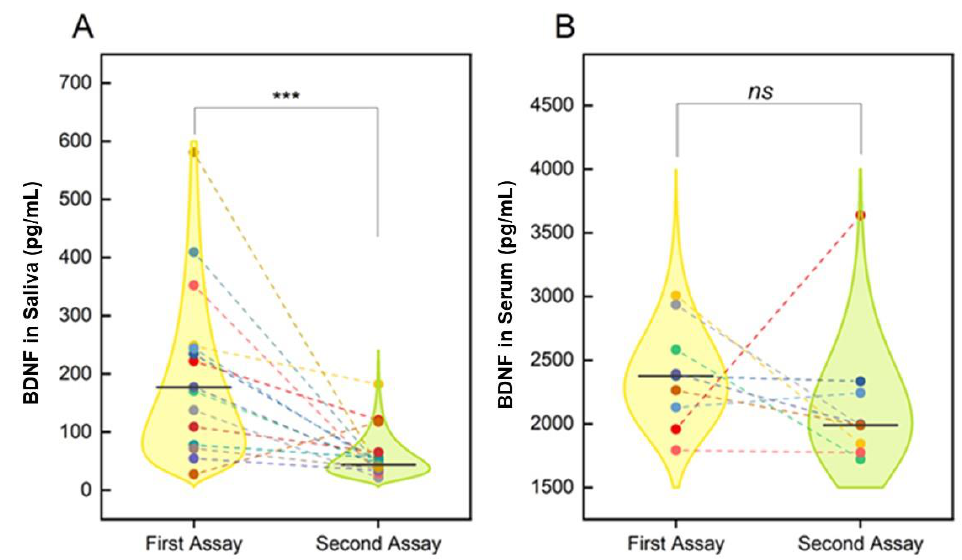
Figure 2. BDNF changes. ( A , B ) Violin plot analyses for the comparison of the BDNF levels in the SARS-CoV-2 acute phase and the follow-up measurement (6 months after the acute phase) in saliva ( A ) and serum ( B ) samples. Data distribution is visualized using the log-normal distribution that best fits the data. Different subjects are highlighted in different colors. and the two paired measures are connected with a dashed line. Median values are reported as continuous horizontal lines. Non-parametric paired Wilcoxon Signed Rank Test (***: p <